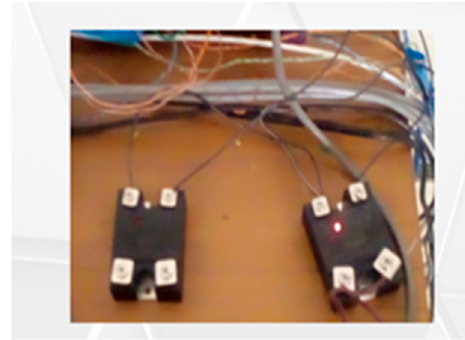
Figure 12. Solid state relay.